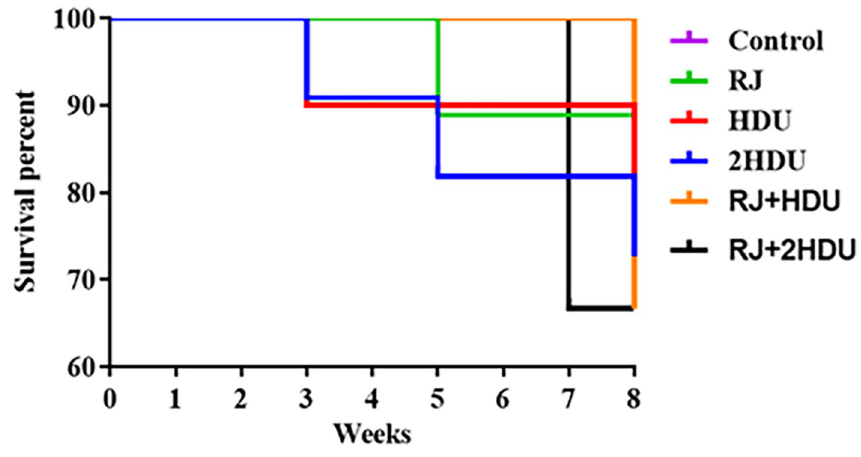
Fig 1. The survival